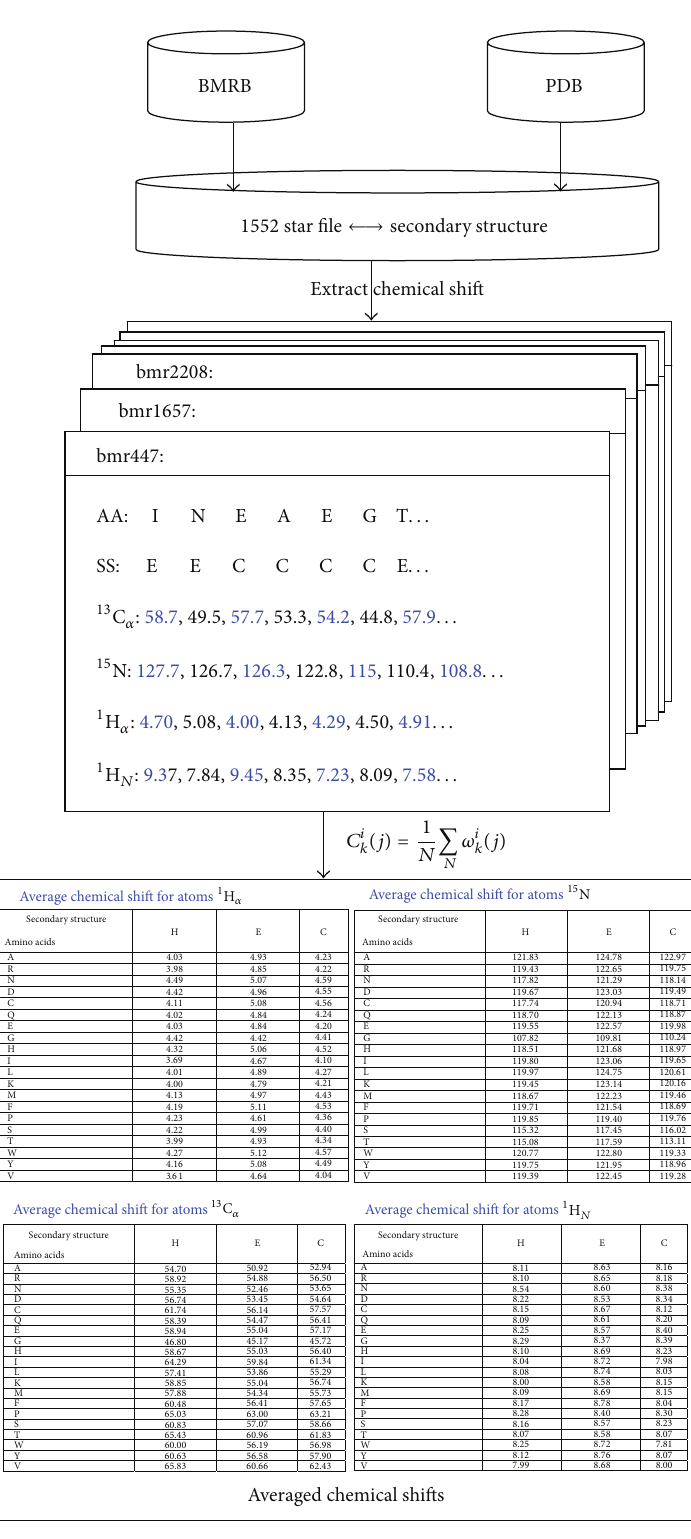
Figure 2: The flowchart of calculating the ACS. The AA denotes the amino acids and the SS denotes the secondary